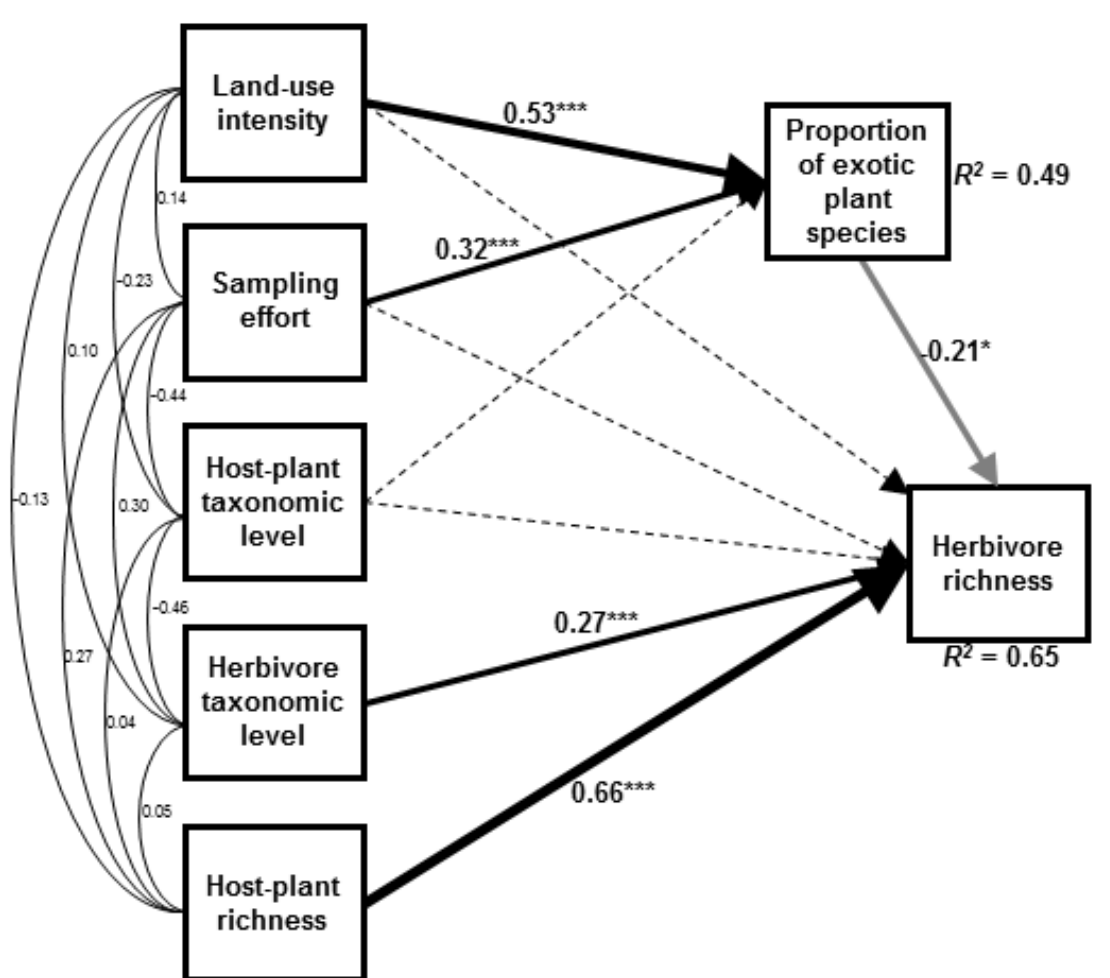
Figure 3. Path analysis for insect richness in the plant-herbivore networks explained by land use intensity, sampling effort, host plant richness, host plant taxonomic level, herbivore taxonomic level, and proportion of exotic host plants. Numbers associated with paths between variables are path coefficients presented as standardized values (scaled by the standard deviations of the variables). Black arrows represent positive effects and grey arrows repre- sent negative effects (* P < 0.05; ** P < 0.01; *** P < 0.001). The thickness of lines and arrows is proportional to effect size. Dashed arrows P < 0.05 (n.s.). Modified of Araújo et al.